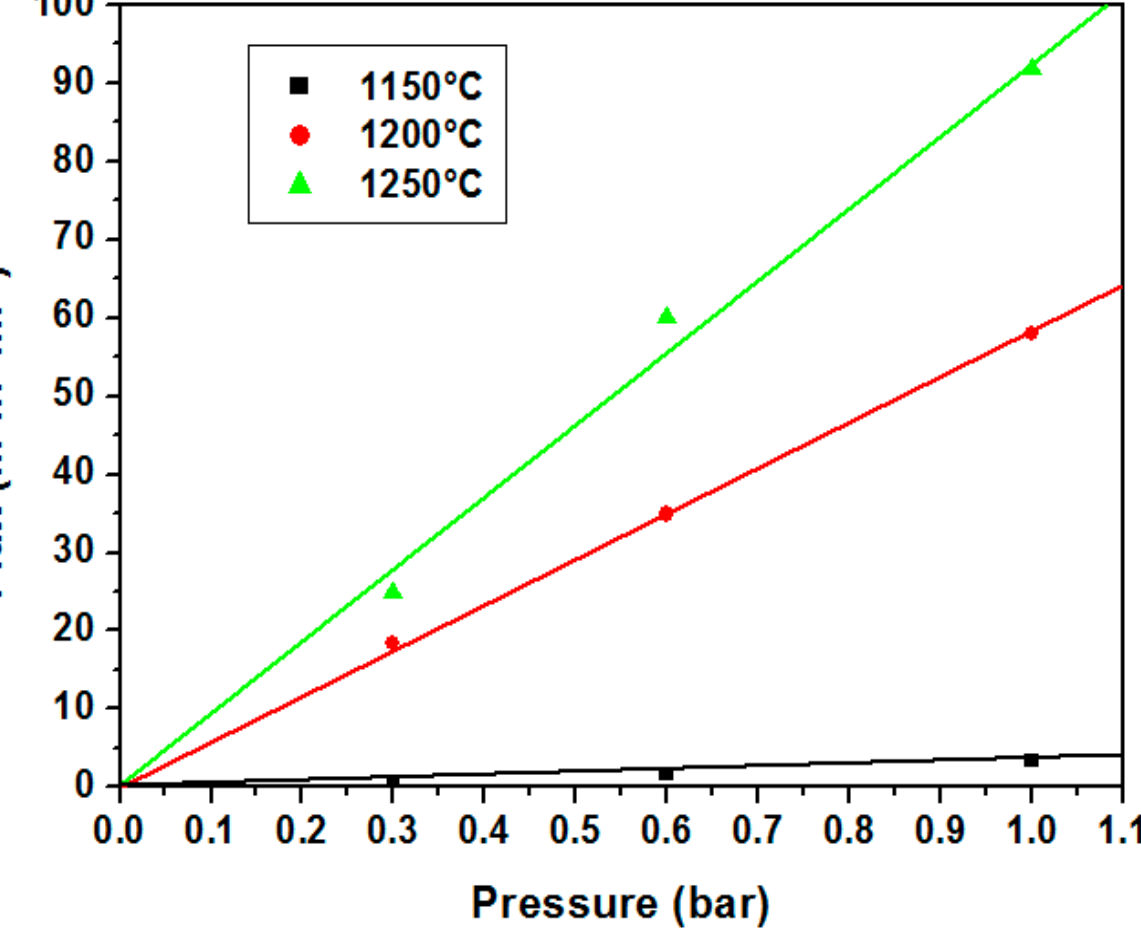
Figure 11. Water flux variation versus pressure for supports sintered at 1150, 1200, and 1250